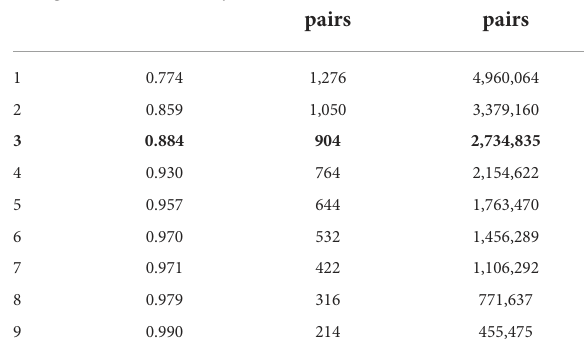
TABLE 2 The accuracy of a binary SVM classifier for pairs of sentences depends on the difference between grade levels (margin). Margin SVM accuracy No. of